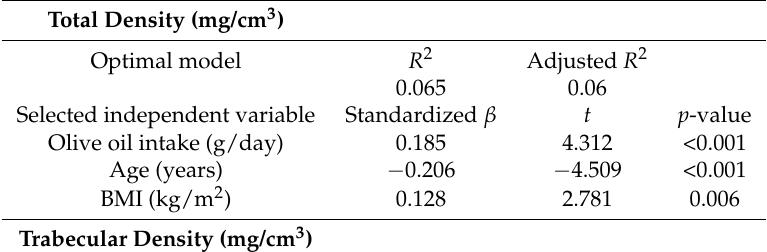
Table 3. Multiple linear regression analysis for the association between vBMD and age, BMI (kg/m 2 ), calcium intake, vitamin D intake, energy intake, and olive oil intake